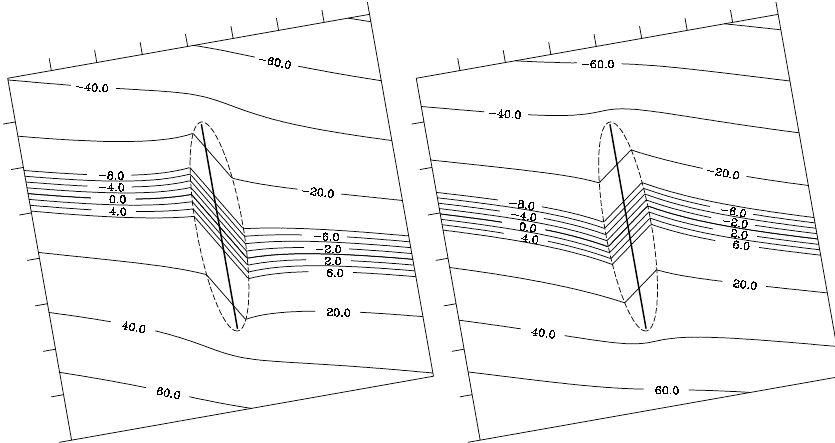
Fig. 10. Equipotentials (in arbitrary units) surrounding uniform, elliptical irregularities in a uniform background electric field. Depleted and enhanced irregularities are shown on the left and right, respectively. The density perturbation is 9% in both cases. The eccentricities of the ellipses is 6. Note that the problem is scale invariant. Fine and coarse spacings are used to plot the equipotential contours to show detail. The equipotentials can be viewed as streamlines of the electron flow, moving from right to left. Fringing fields are shown extending outside the irregularities. Inside, the electric fields are uniform. In an actual large-scale wave, enhancements and depletions would abut against one another, forming a zig-zag pattern in the equipotential